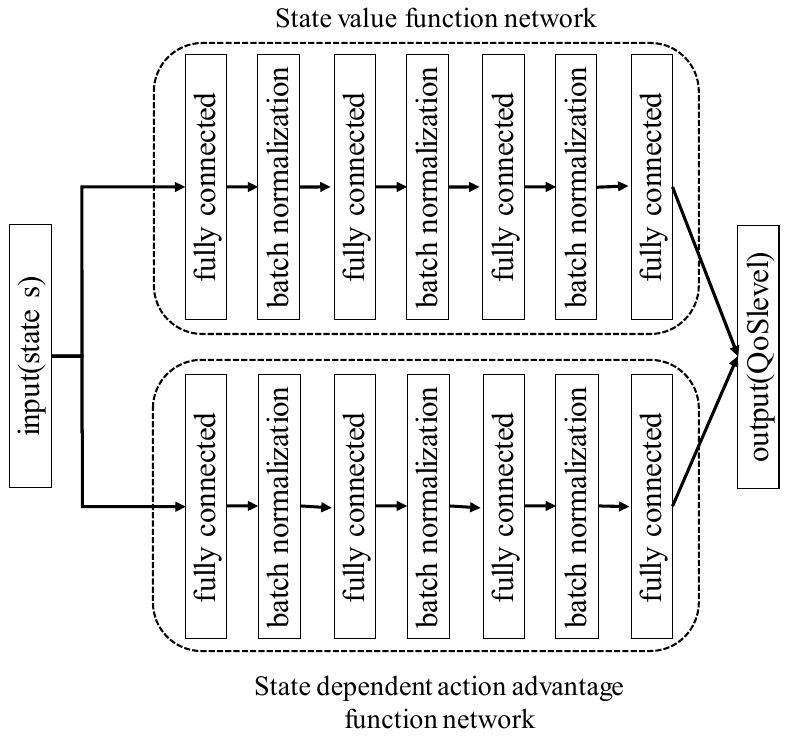
Figure 3. Network architecture of the proposed method. Table 2. Network environment model.